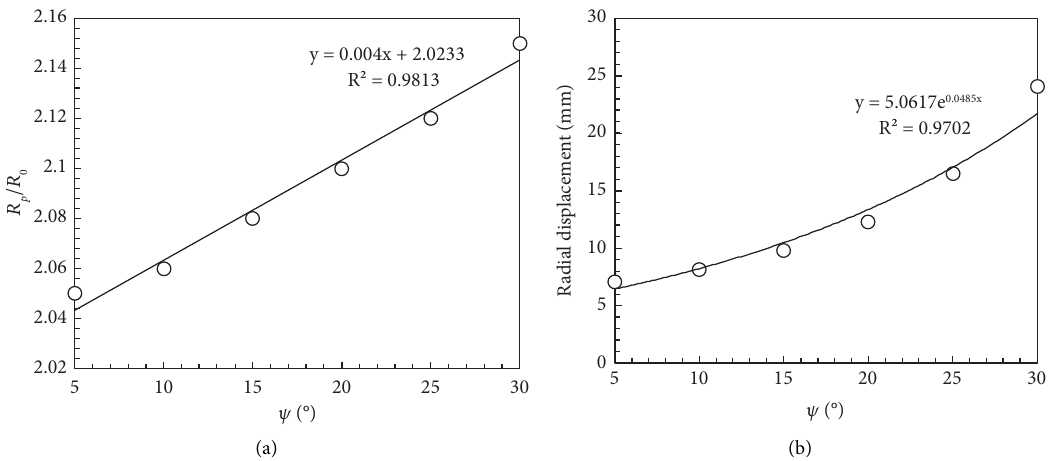
Figure 8: Relationship between R p / R 0 , radial displacement, and different ψ . (a) R p / R 0 . (b) Radial